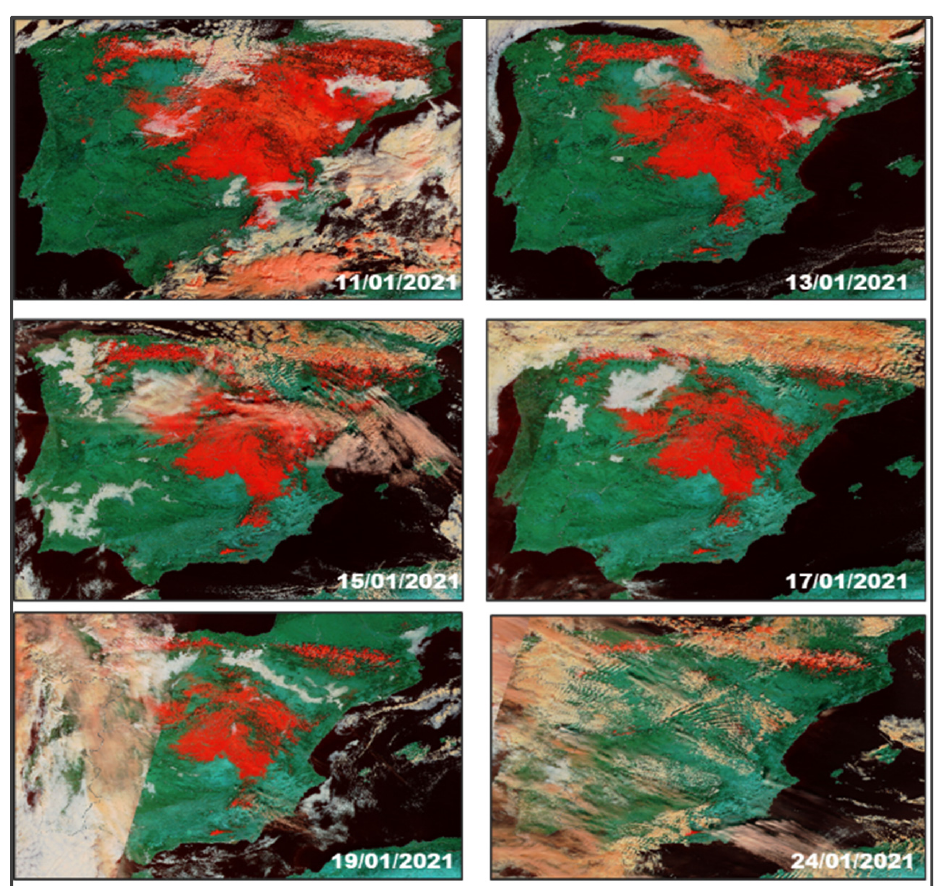
Figure 3. MODIS/TERRA images, combination 3-6-7 (R-V-A). Source NASA (2021) [39]. In greater detail, the Landsat image of 1 November 2021 has made it possible to identify the covered and free sectors of the snow cover not only in the city of Madrid but throughout the Community of Madrid. In the municipality of Madrid, temperatures ranged from the minimum, − 11 to − 10 ◦ C, in forest areas and bare soils (cyan tones), to the least low occurring in the central district, with − 3.5 to − 5 ◦ C (pink tones and reddish) (Figure 4). Despite the exceptionally cold values reached on those days, the thermal pattern of the “heat island” of Madrid remains, meaning that the less rigorous values appear in the centre; by contrast, the lowest ones appeared in the forest spaces and in the highest districts of the city [53]. These lower temperatures of the urban green enclaves [15,21,54] exceptionally low on these dates, will have a clear negative impact on the forest of the municipality of